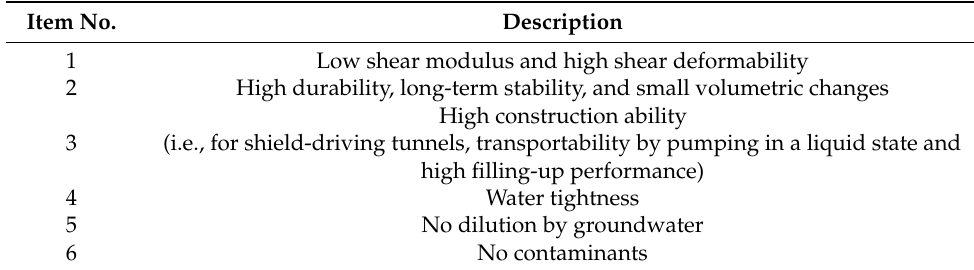
Table 1. Requirements for seismic isolation materials.